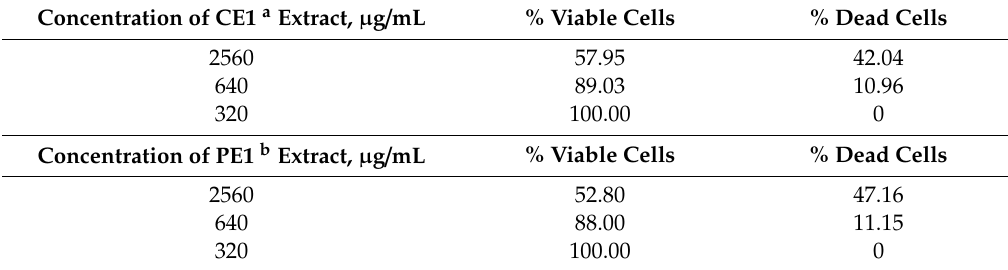
Table 5. Cytotoxicity of the celery and parsley SFE extracts. Concentration of CE1 a Extract, µ g / mL % Viable